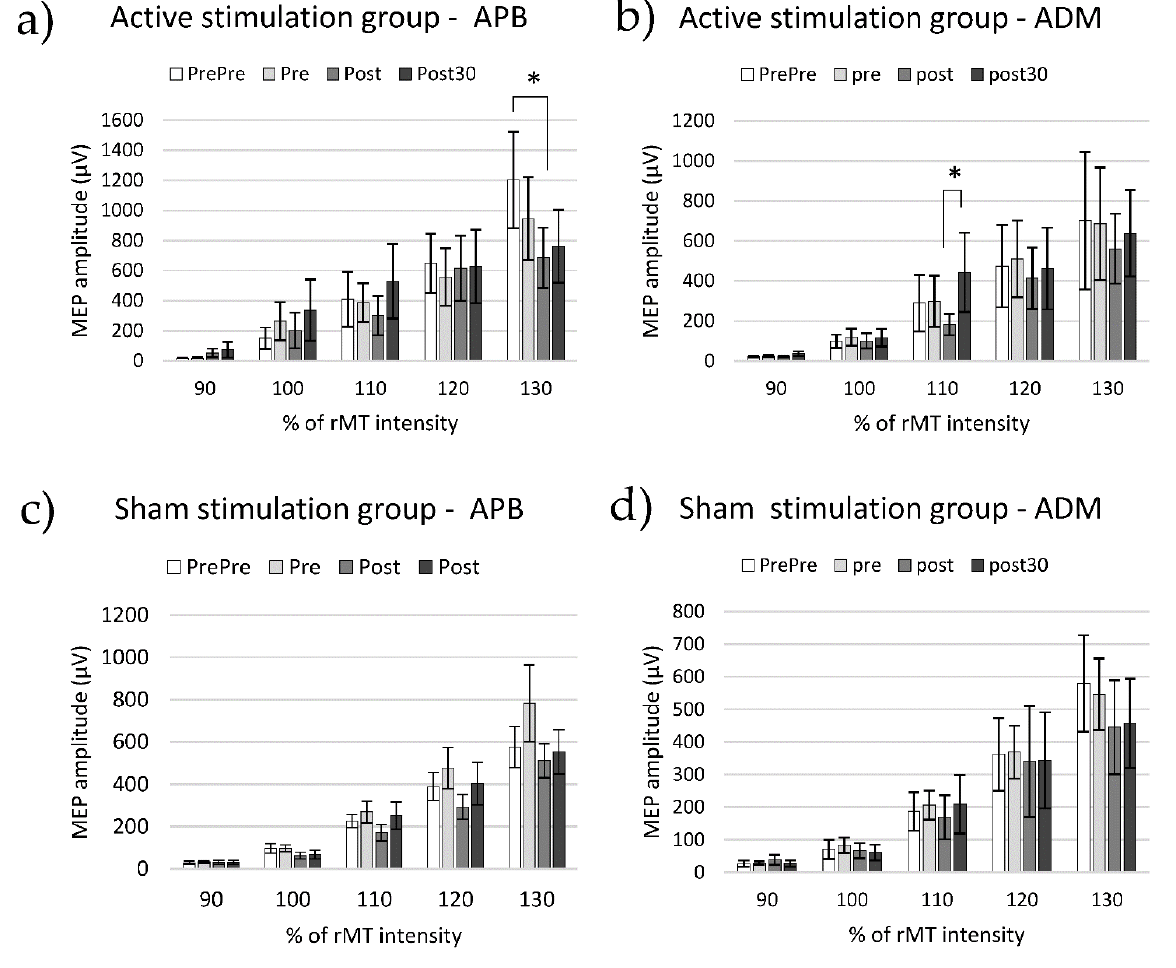
Figure 4. Recruitment curves . Raw data of Mean, SE, and significant differences of the peak-to-peak MEP amplitude for APB and ADM muscles in Active and Sham groups, and the different experimental times at each intensity level. Recruitment curves of ( a ) APB muscle in Active group, ( b ) ADM muscle in Active group, ( c ) APB muscle in Sham group, ( d ) ADM muscle in Sham group. * corresponds to significance between p = 0.05 and p = 0.01.